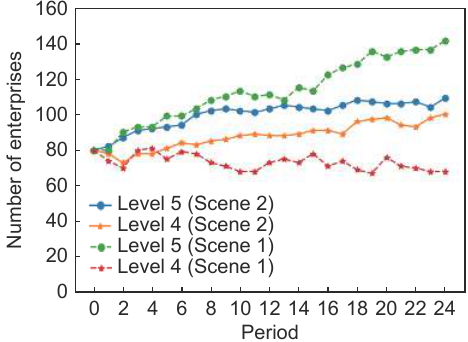
Fig. 3 Scenes 1 and 2: Changes of number of low-, middle-, and high-level enterprises.